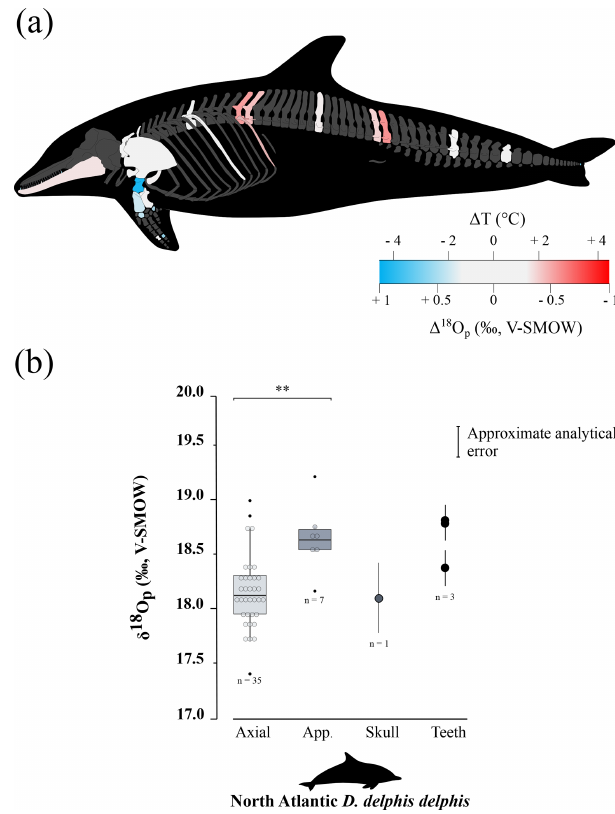
Figure 1. (a) Oxygen isotope variability within the skeleton of a North Atlantic D. delphis delphis (M.1162). Bone (cid:49) 18 O p corre- sponds to the difference between bone δ 18 O p value and an average value of the skeleton expressed as its mid-range value ( (δ 18 O max − δ 18 O min )/ 2). For paired skeletal elements as well as vertebrae cen- tra and neural spines, the mean value is used. (b) Boxplots showing the δ 18 O p values of skeletal regions for a North Atlantic D. delphis delphis . Asterisks indicate the significance of the observed differ- ences between pairs of groups ( ∗∗ for p< 0 . 01). Outliers are plotted as small black circles. Abbreviation: App. (appendicular